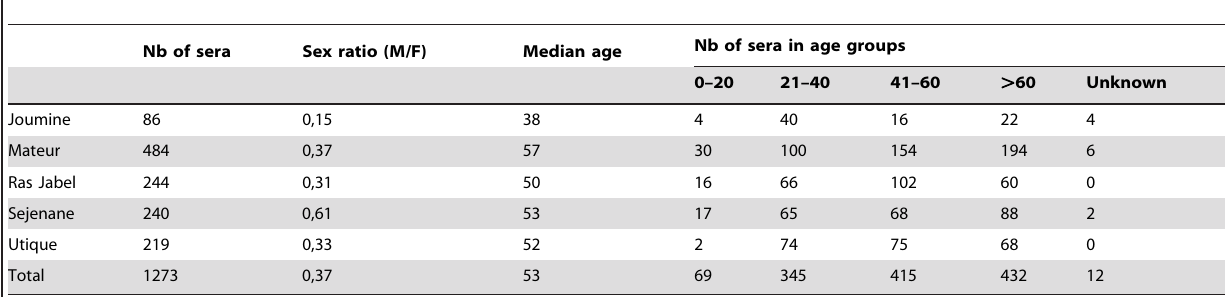
Table 1. Demographic characteristics of the panel of studied sera.